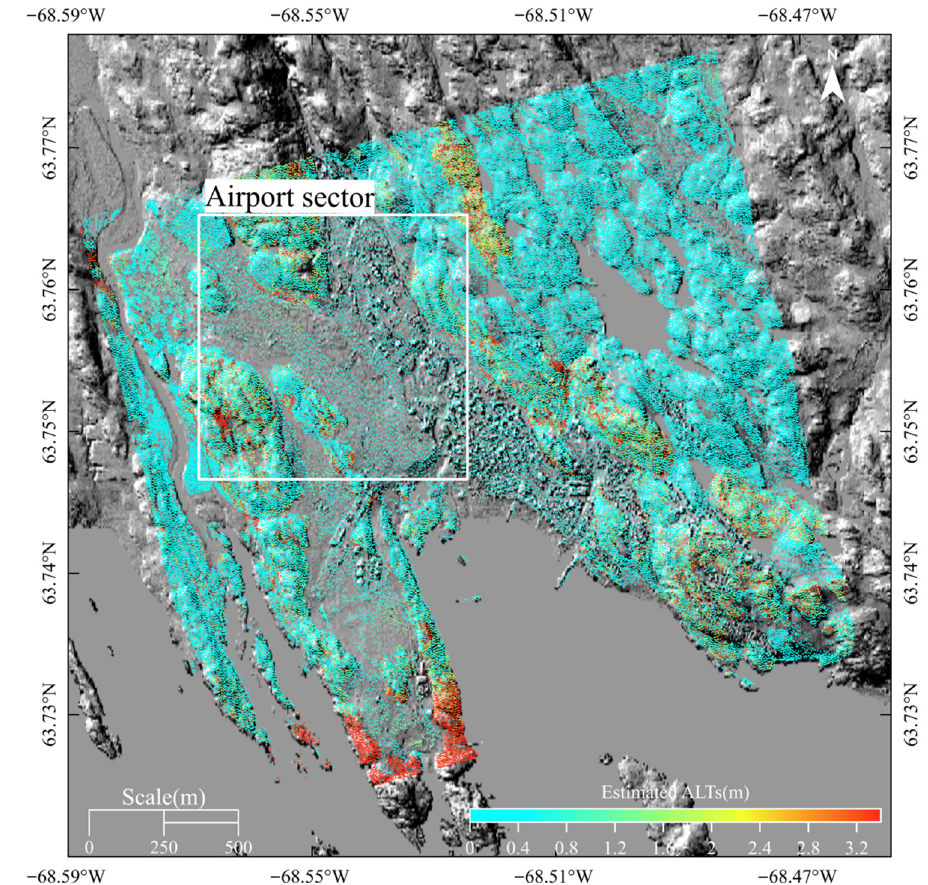
Figure 6. Estimated ALTs.